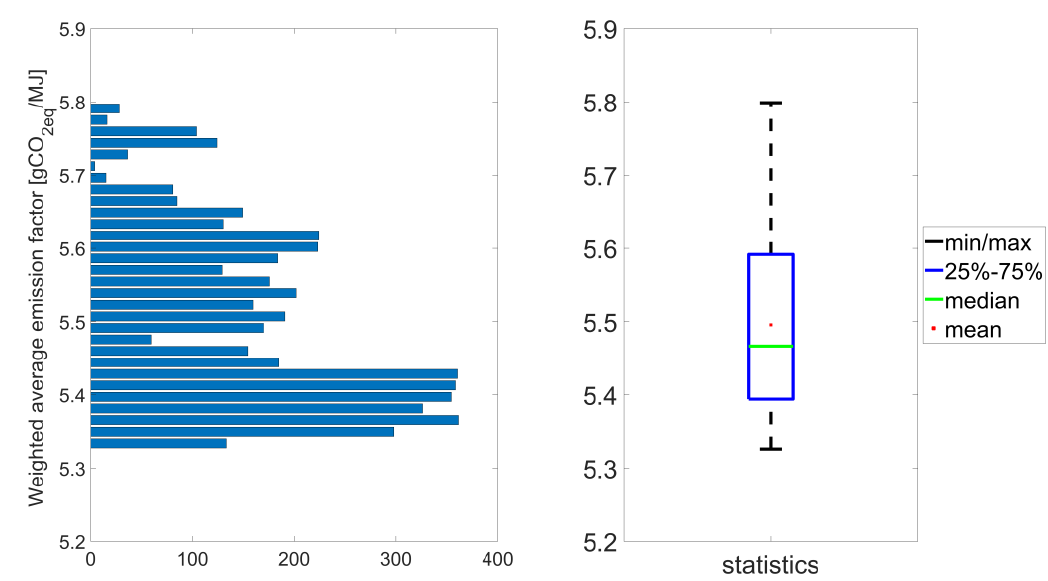
Figure 7. Histogram and main statistics of the distribution of weighted average emission factor of motor fuels.